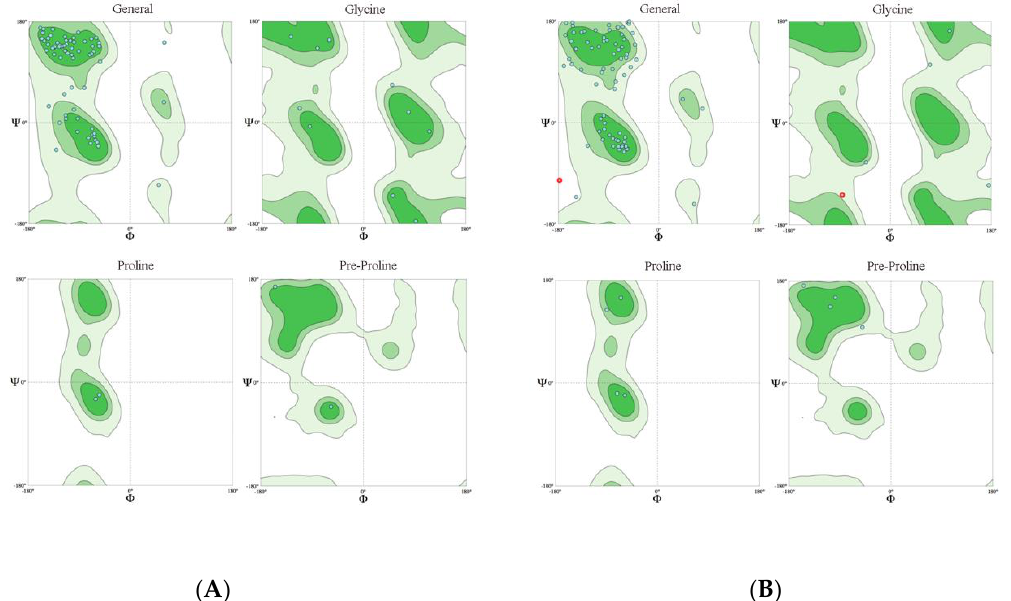
Figure 3. Evaluation of the three-dimensional structure by MolProbity: ( A ) Bx-TLP-2 and ( B ) Bx-CPI.